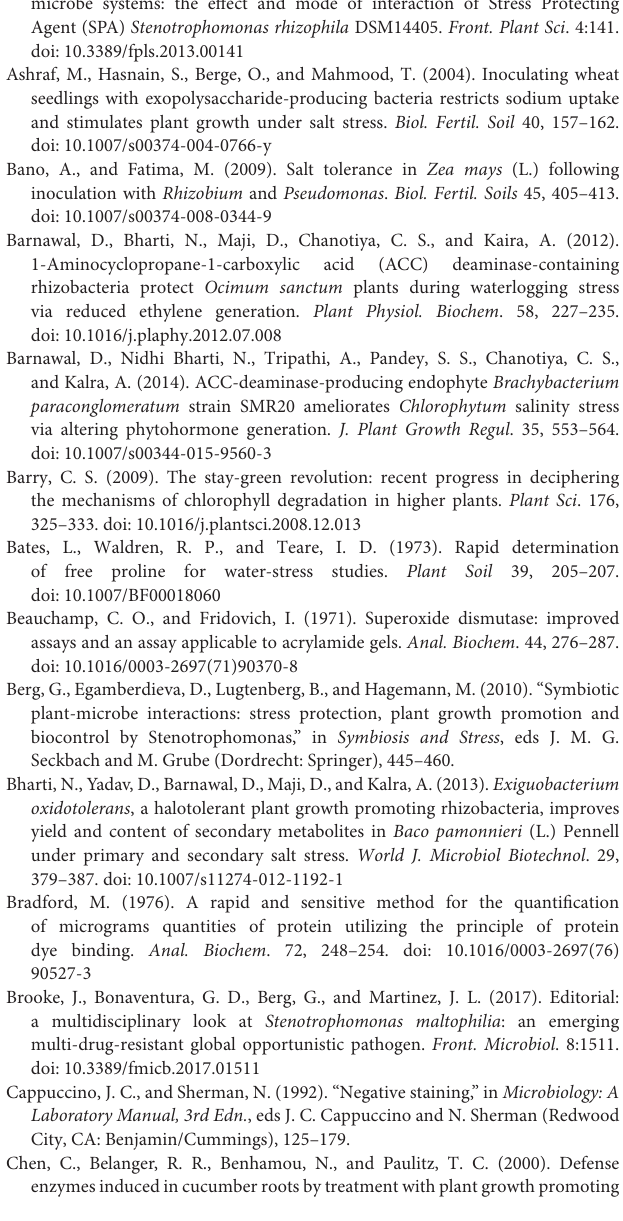
The tree was obtained using neighbor- joining method of software packages Mega version 6.0, at the bootstrap value of ( n = 1,000). Supplementary Figure 2 | Siderophore production by the test isolate S. maltophila SBP-9 on CAS-agar plate. Supplementary Figure 3 | nif -H gene amplification in S. maltophila SBP-9. Supplementary Figure 4 | Tracking of colonization of S. maltophila SBP-9 through ERIC-PCR profile of bacterium colonized on wheat plants and confirmation of its identity using profile of pure culture (Lane M: DNA ladder SM0311, Lane A: control DNA, Lane B: DNA of S. maltophila SBP-9 isolated from treated